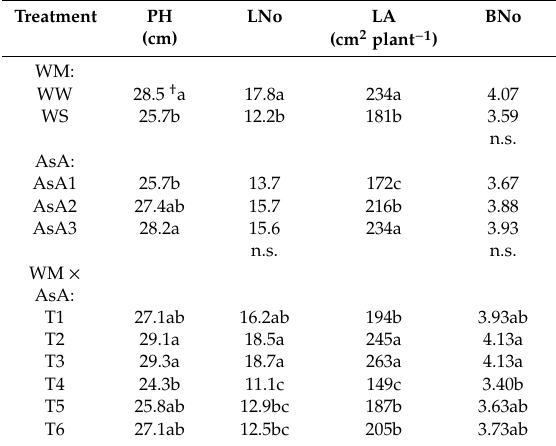
3.73ab † Mean values within the same column for each trait with the same lower-case letter are not significantly di ff erent according to Tukey’s HSD test at p ≤ 0.05, n.s.—not significant. Measurements were done at 46 day after sowing. WW, well watered with 100% of evapotranspiration (ETc) throughout the season; WS, water stress with 50% of ETc